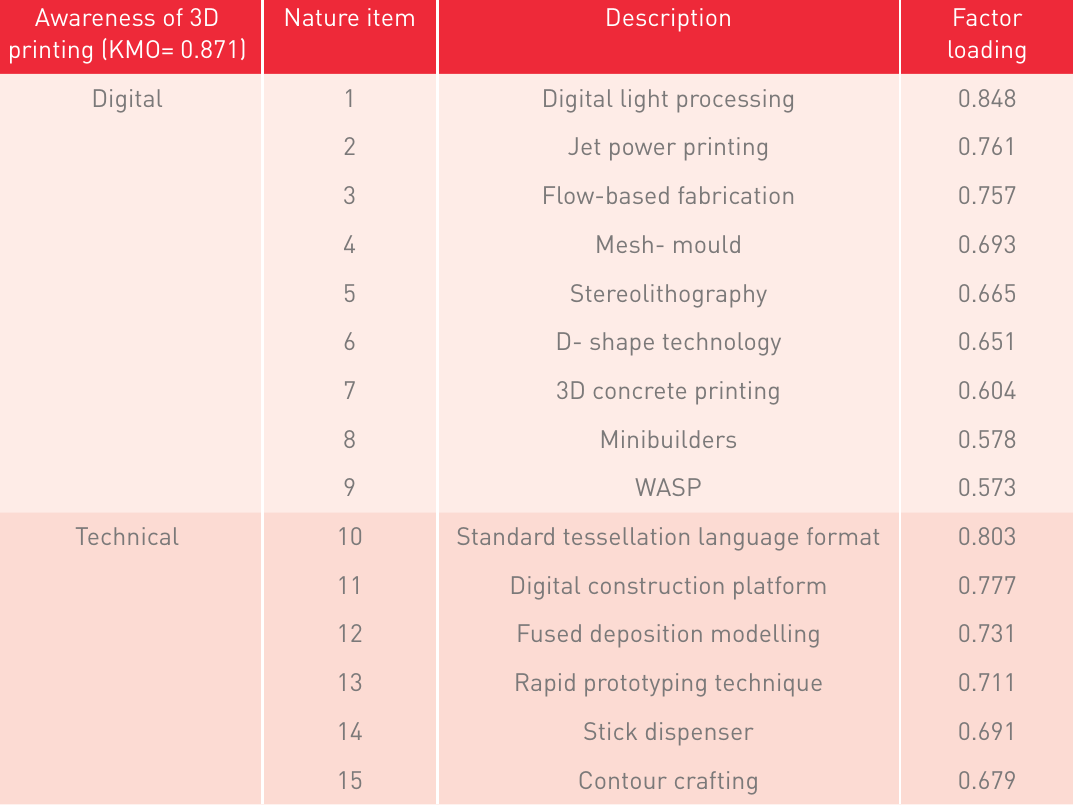
Table 11. Related component of the awareness of 3D printing Awareness of 3D Nature printing (KMO= 0.871)